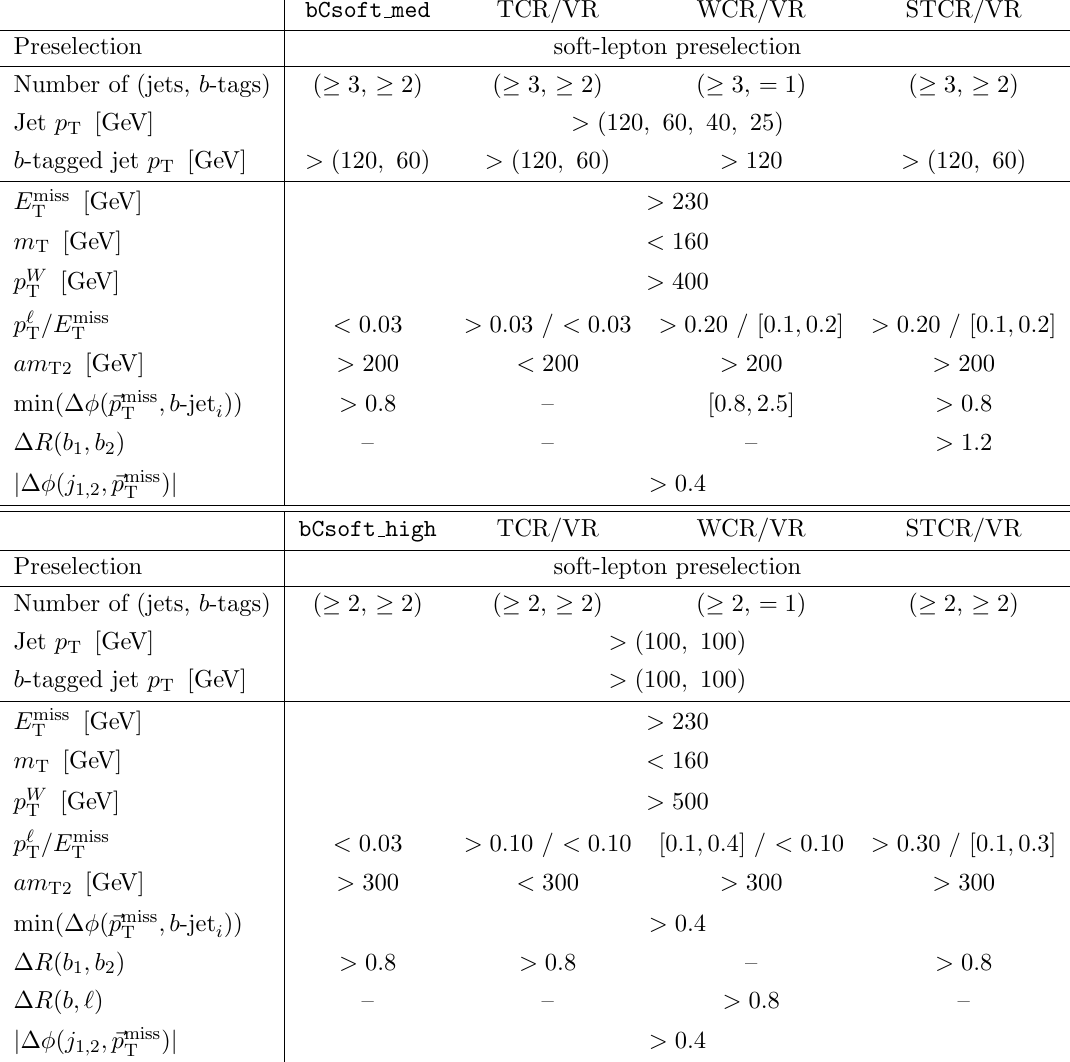
Table 21 . Overview of the selections for the bCsoft med and bCsoft high signal regions, as well as the associated control regions for t (cid:22) t (TCR), W +jets (WCR), and single-top Wt (STCR), and the validation regions targeting t (cid:22) t (TVR), W +jets (WVR), and single-top Wt (STVR) backgrounds. List values are provided in between parentheses and square brackets denote